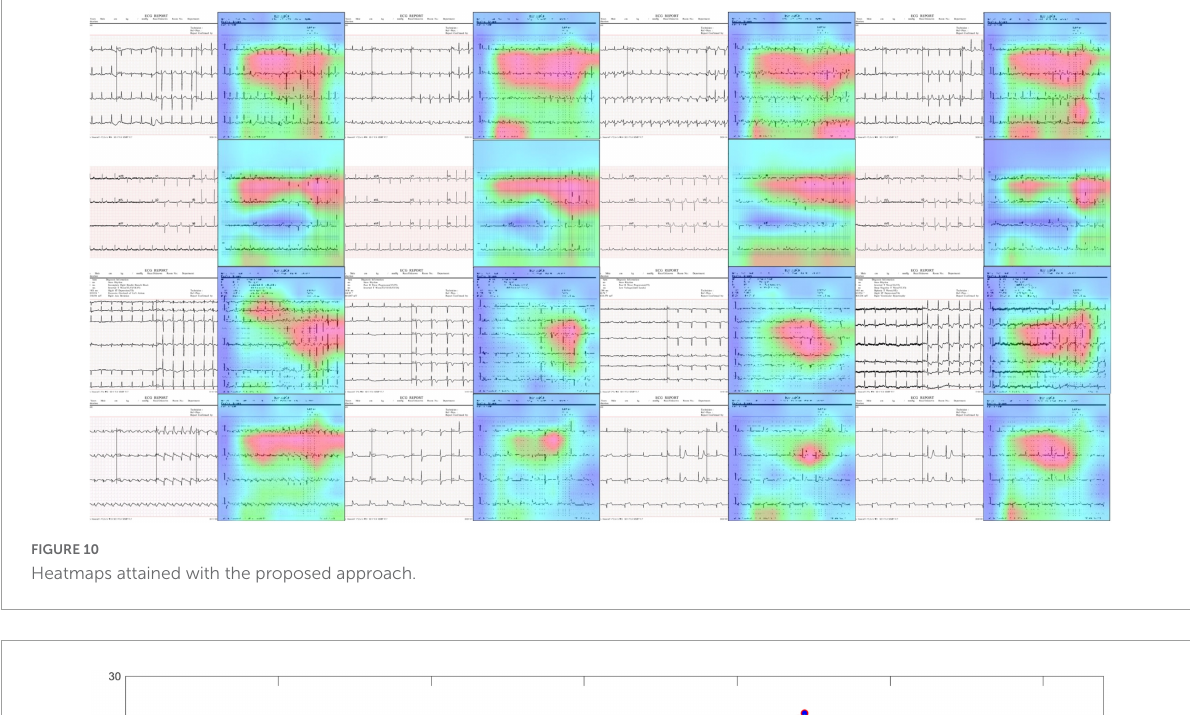
FIGURE10 Heatmaps attained with the proposed approach.